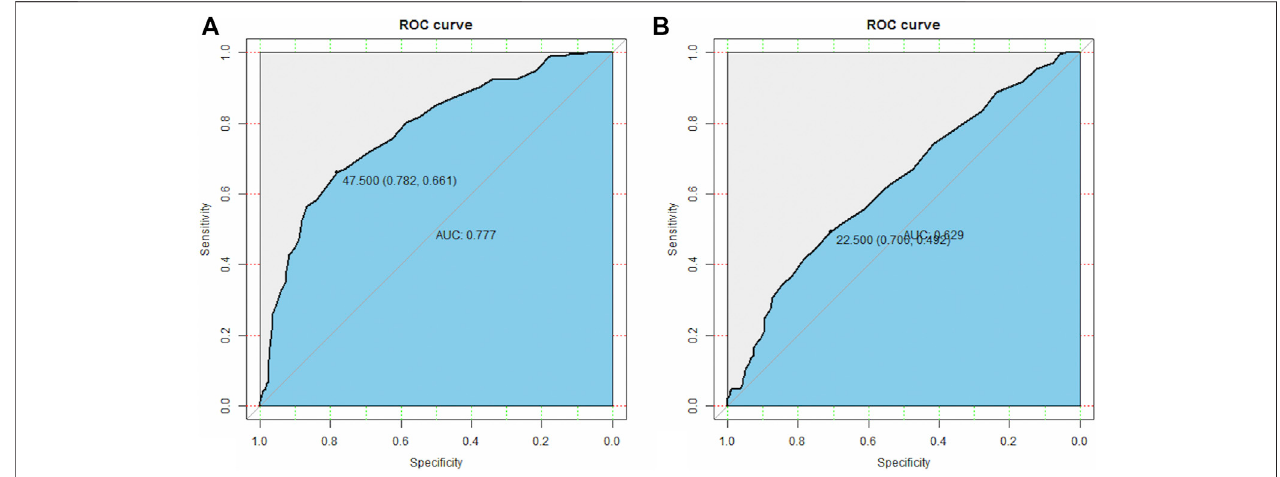
FIGURE 5 | Optimal cut-off value of age and mass size. (A) The optimal cut-off of the age is 47.5 (B) The optimal cut-off of mass size is 22.5. The ROC analyses were based on continuous data of age and mass